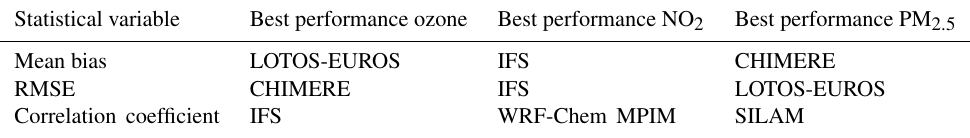
Table 5. Best model